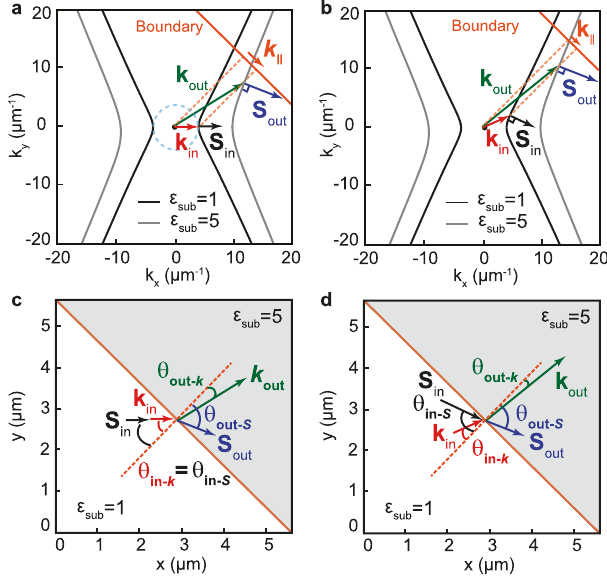
Fig. 1 Schematics of refraction of polaritons between two hyperbolic media. a Isofrequency curves of polaritons propagating in a hyperbolic slab (with ε x = − 5; ε y = 1; ε z = 5) placed on two different semi-in fi nite substrates with ε sub = 1 (black curve) and ε sub = 5 (gray curve) that de fi ne two different hyperbolic media (medium 1 and 2, respectively). The incident wave in medium 1 is characterized by collinear k in and S in (as in an isotropic medium, indicated by a dashed cyan circle). Upon refraction into medium 2, momentum conservation at the boundary (orange line), k jj ( k k ¼ k in (cid:3) sin φ , where φ is the angle of the boundary), is ful fi lled by non-collinear k out and S out . The dashed orange lines represent the normal to the boundary. b The general case of refraction between two hyperbolic media is represented by an incident wave from medium 1 with non-collinear k in and S in (normal to the isofrequency curve). When the wave refracts into medium 2, momentum conservation at the boundary (orange line) is ful fi lled by non- collinear k out and S out . The dashed orange lines represent the normal to the boundary. c Real-space illustration of refraction between two hyperbolic media shown in a where the incident wave exhibits collinear k in and S in , i.e. θ ¼ θ θ ≠ θ in (cid:2) k in (cid:2) S , giving rise to non-collinear k out and S out , i.e. out (cid:2) S out (cid:2) k . d Real-space illustration of the general case of refraction between two hyperbolic media shown in b where both the incident and the outgoing ≠ θ ≠ θ wave exhibits non-collinear k and S , i.e. θ and θ . The in (cid:2) k in (cid:2) S out (cid:2) k out (cid:2) S tangents parallel to both hyperbolas give rise to bending-free refraction, i.e. θ (cid:4) θ . The orange dashed lines in c , d represent the normal to the in (cid:2) S out (cid:2) S boundary. The white and gray regions in c , d correspond to α -MoO 3 /air and α -MoO 3 /SiO 2 ,